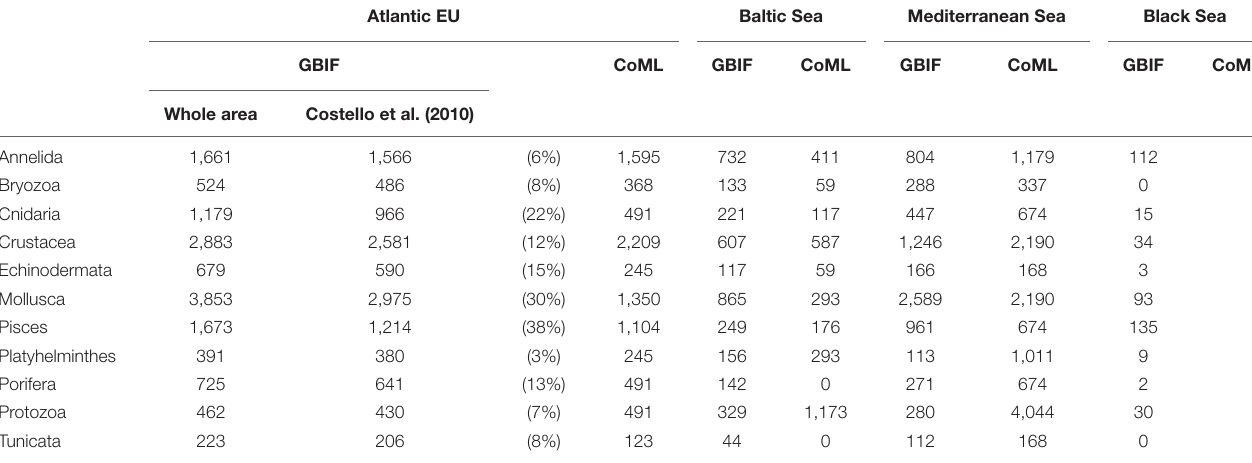
TABLE 2 | Number of species per basin and taxa reported in GBIG and Costello et al. (2010) when analyzing biodiversity information from the Census of Marine Life (CoML). Atlantic